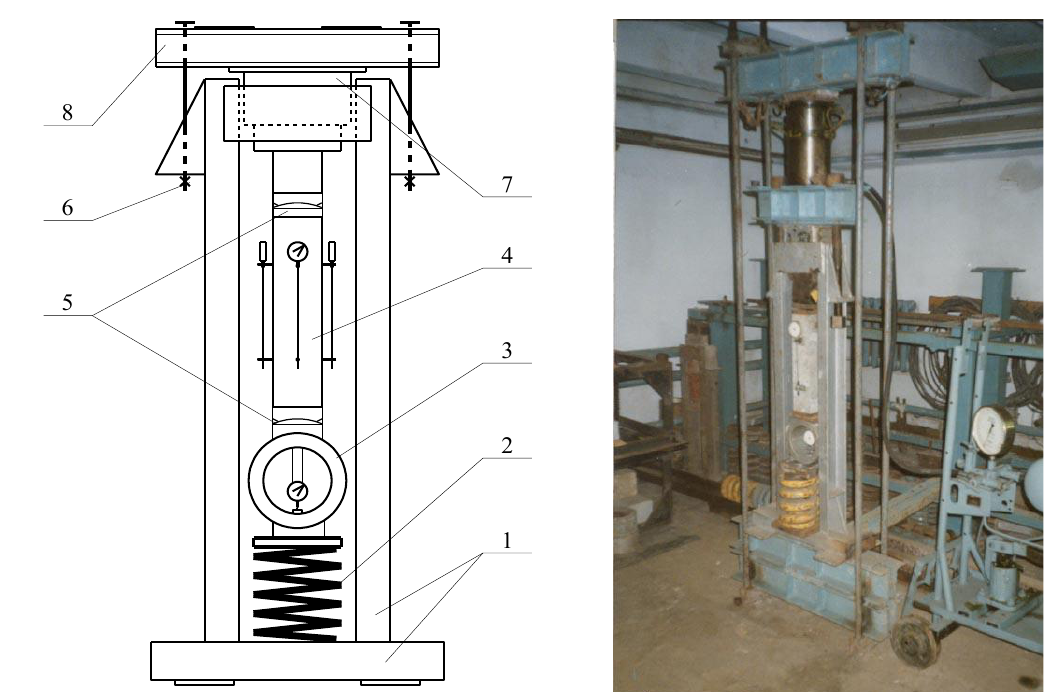
Figure 6. Scheme and general view of the power stand for loading prisms and general view of the power stand for loading of concrete prisms with long-term loading: 1 — frame of the power stand; 2 — springs; 3 — ring dynamometer; 4 — prism; 5 — spherical hinge; 6 — fixing strands; 7 — heel for load transfer; 8 — distribution, traverse.